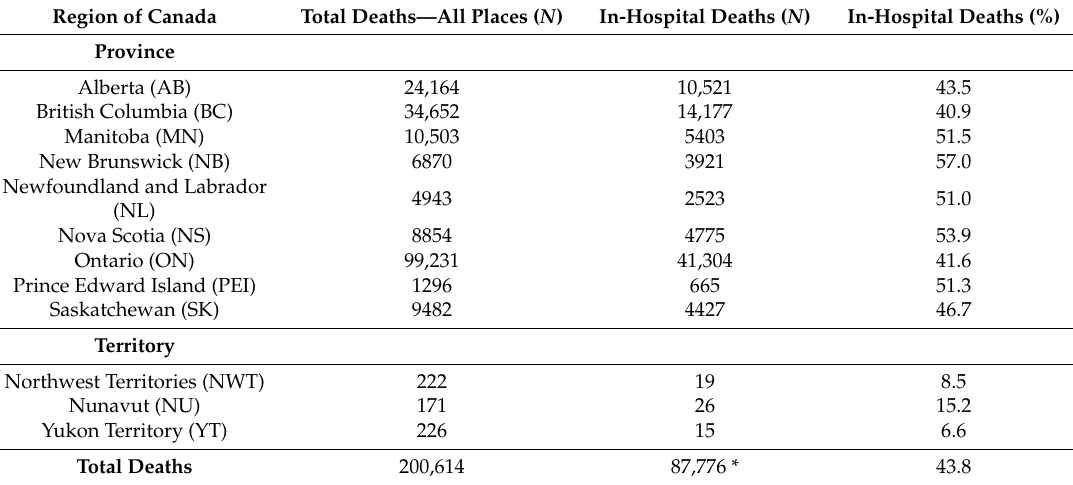
Table 1. Hospital deaths across Canada as a proportion of total deaths (2014–2015).